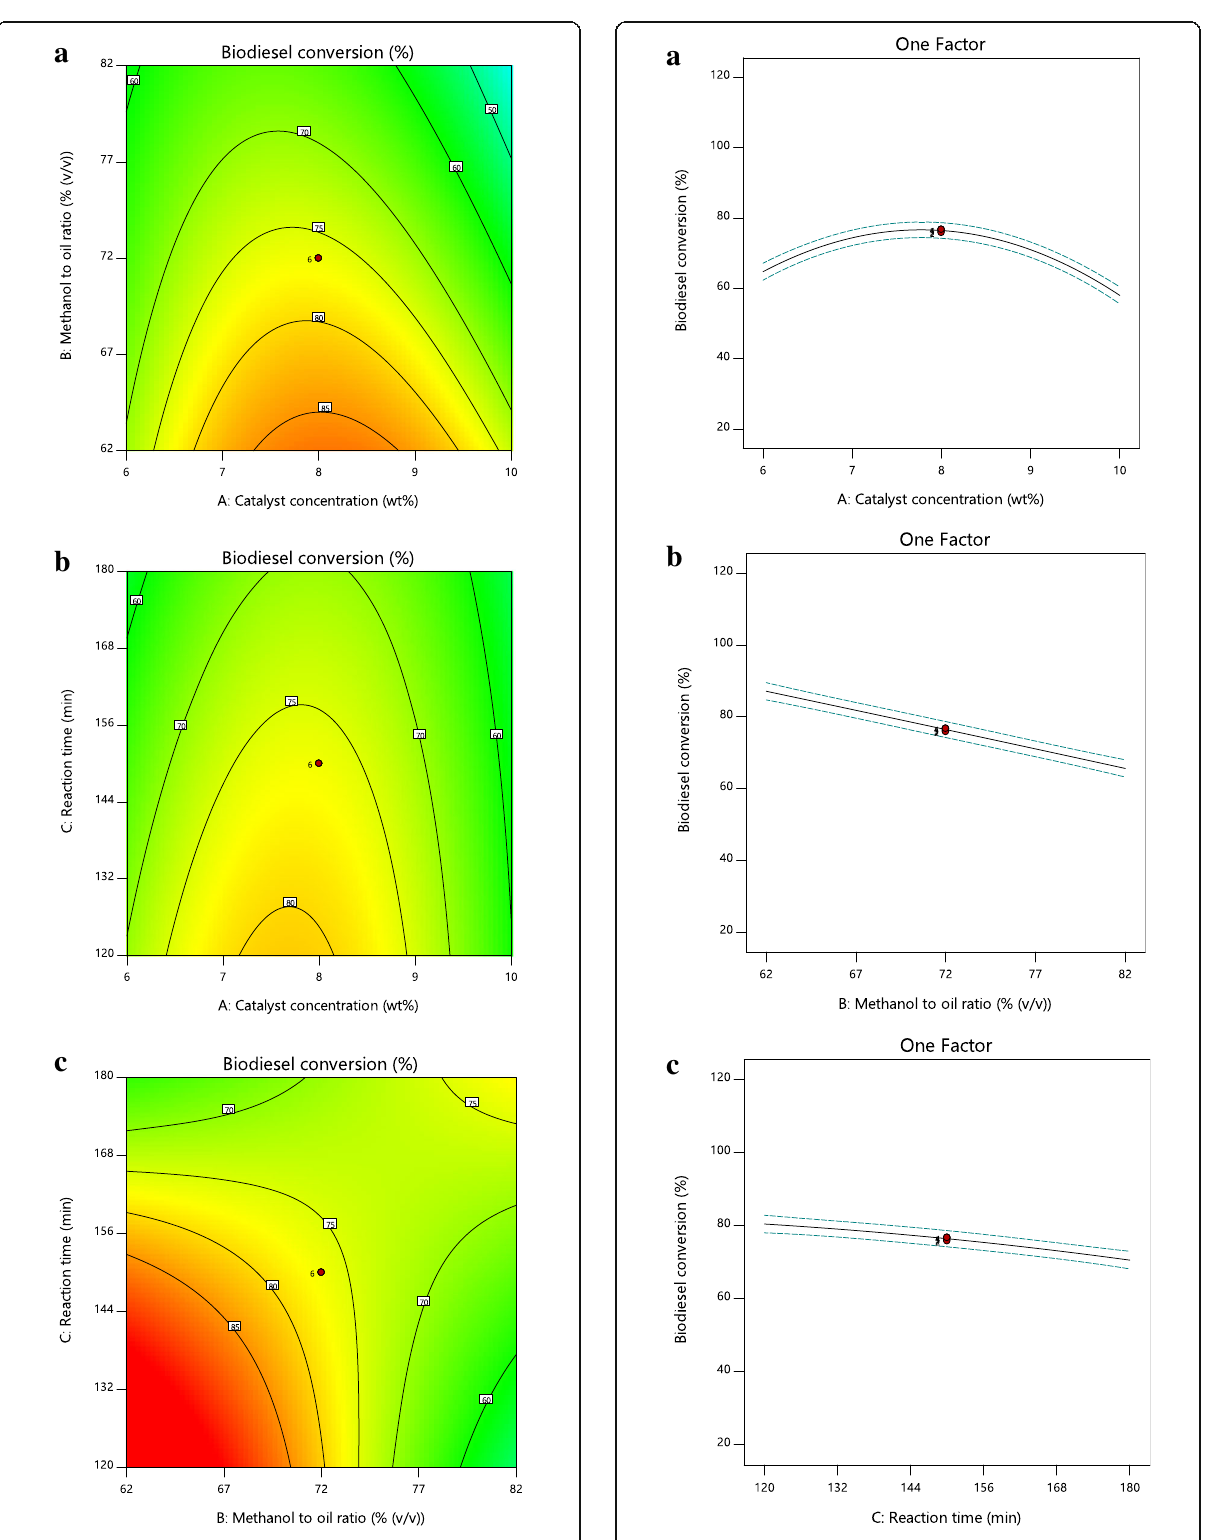
Fig. 6 Effect of parameters on biodiesel conversion ( a ) catalyst concentration and methanol to oil volumetric ratio, ( b ) catalyst concentration and reaction time, and ( c ) methanol to oil volumetric ratio and reaction time